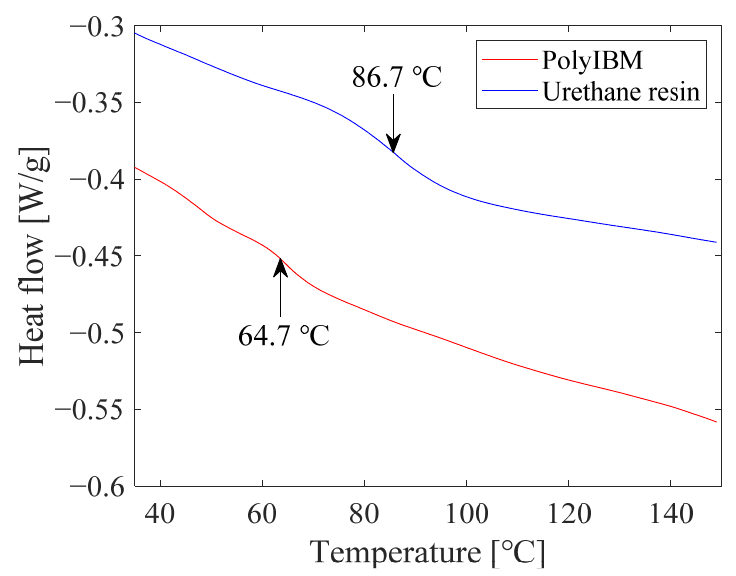
Figure 11. Thermogram of polyIBM and urethane resin. Table 2. Glass transition temperature of polyIBM and urethane resin.